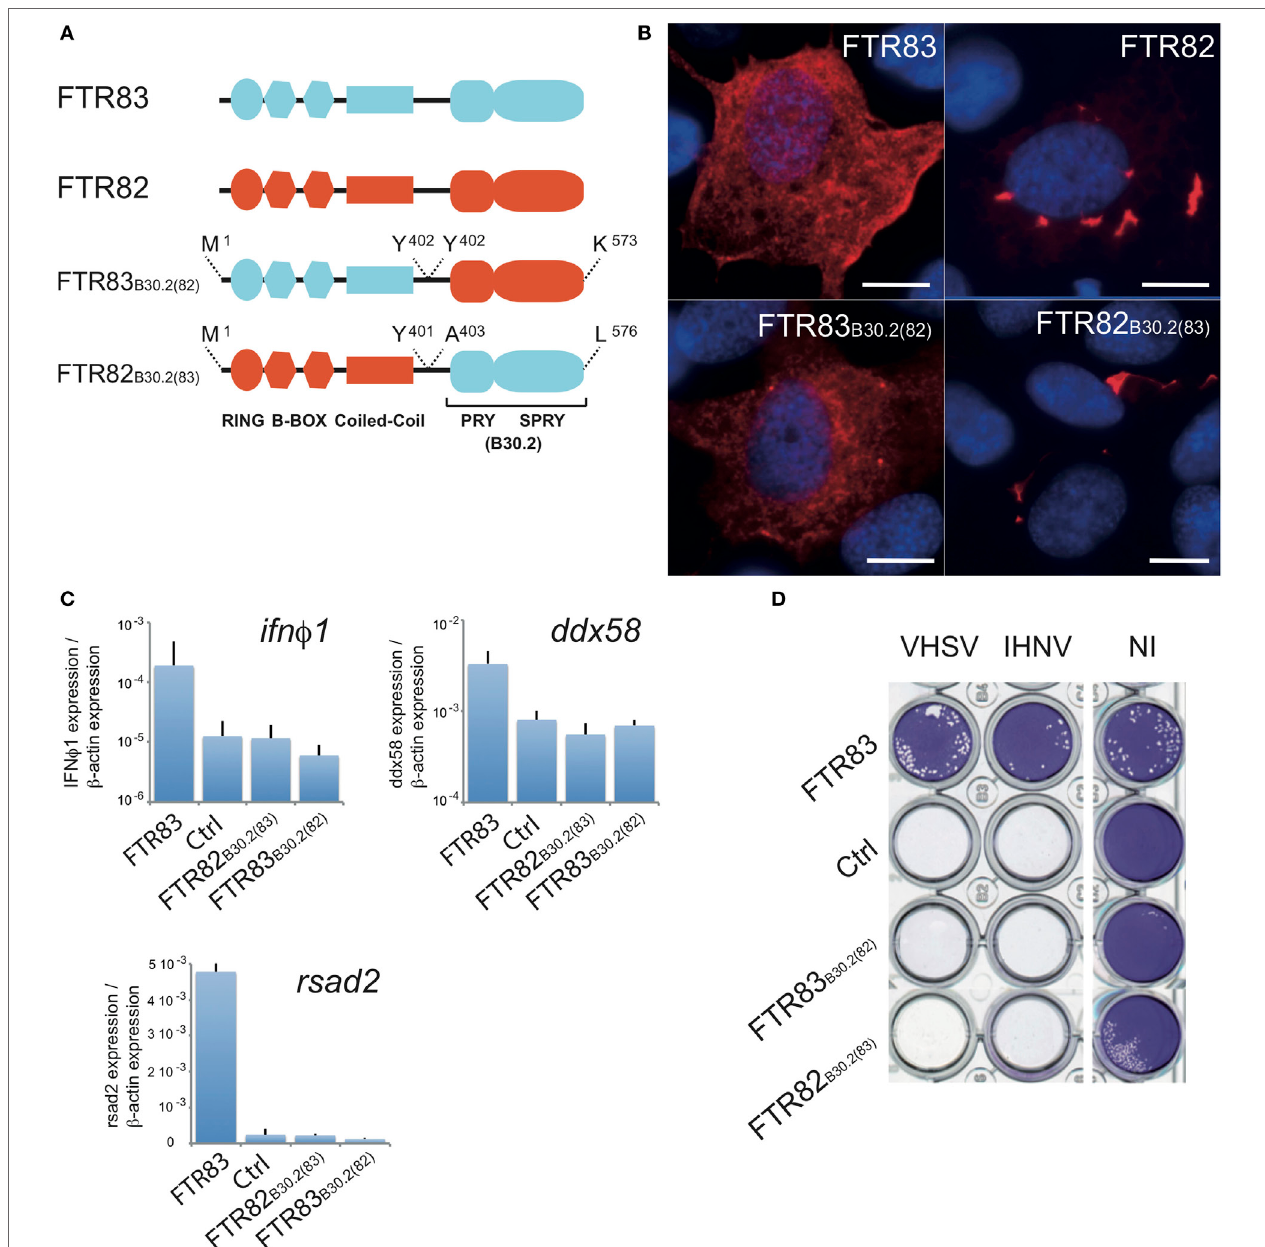
FigUre 6 | Ftr83 domains involved in viral restriction . (a) Schematic representations of finTRIM chimeras produced by combination of FTR82 and FTR83 domains. (B) Subcellular expression pattern of FTR83, FTR82, and chimeric proteins. HA-tagged FTR83, FTR82, and Ftr83 B30.2(82) and V5-tagged Ftr82 B30.2(83) were immunostained with relevant antibodies on transiently transfected epithelioma papulosum cyprinid (EPC) cells at 72 hpt. FTR proteins appear in red and nuclei in blue after DAPI staining. Scale bars: 10 µm. (c) Ifn φ 1 , ddx58 , and rsad2 transcripts are not induced by FTR82 B30.2(83) and FTR83 B30.2(82) chimeras. Results of RTQPCR were normalized on the β -actin expression: measured ratio of cDNA of interest/ β -actin cDNA is shown. Mean and SD are shown, for three independent experiments. (D) Cytopathic effect of novirhabdoviruses (IHNV and VHSV) on transiently transfected EPC expressing full length FTR83 (FTR83), FTR chimeras FTR83 B30.2(82) or FTR82 B30.2(83) , or mock-transfected cells (Ctrl). Transfected cells were infected at MOI1 72 hpt, and viral-induced cytopathic effect was assessed by crystal violet staining at 72 hpi. Mock-transfected cells (Ctrl) and non-infected cells (NI) were used as controls.